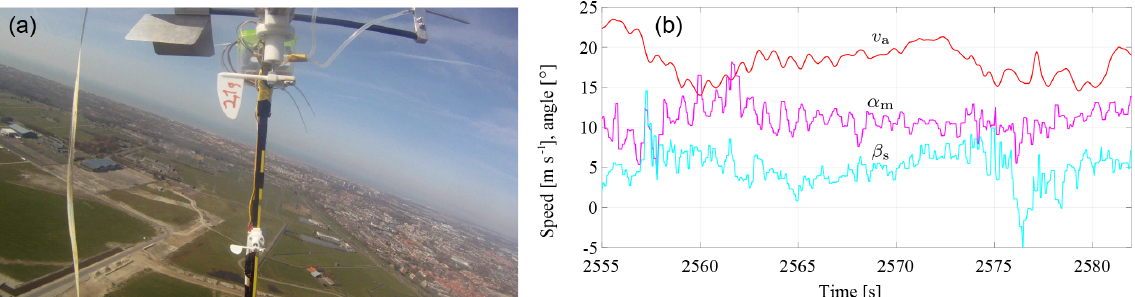
Figure 12. Video still of the relative measurement setup taken from the right power line ( a ), raw values of apparent flow velocity v a , and inflow angles α m and β s recorded over time at the beginning of a representative traction phase ( b